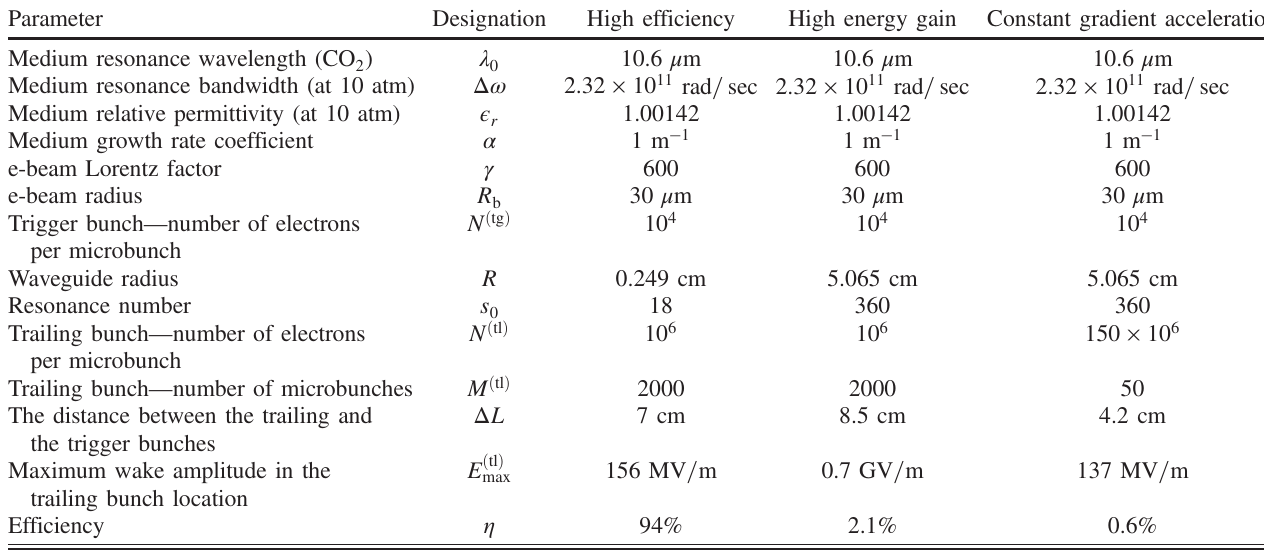
TABLE II. Simulation parameters of the three accelerating configurations. For both the trigger and the trailing bunches